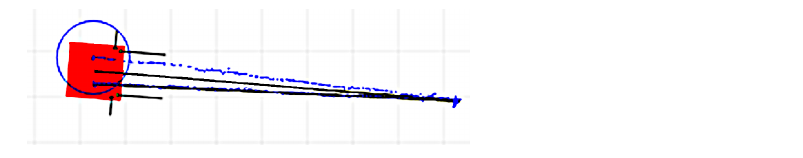
Figure 9. Rotation correction factor determination by using the IPS determination in the second